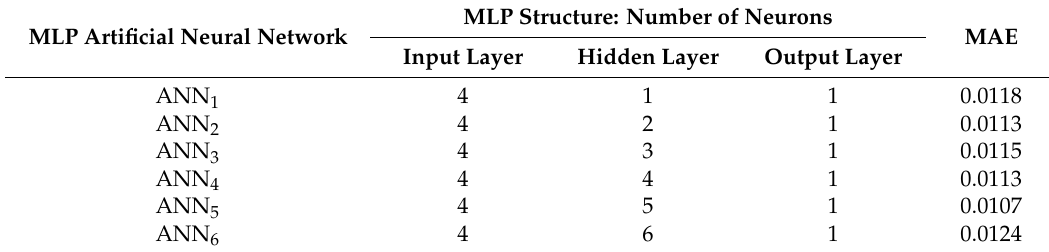
Table 1. Results for different ANN structures.